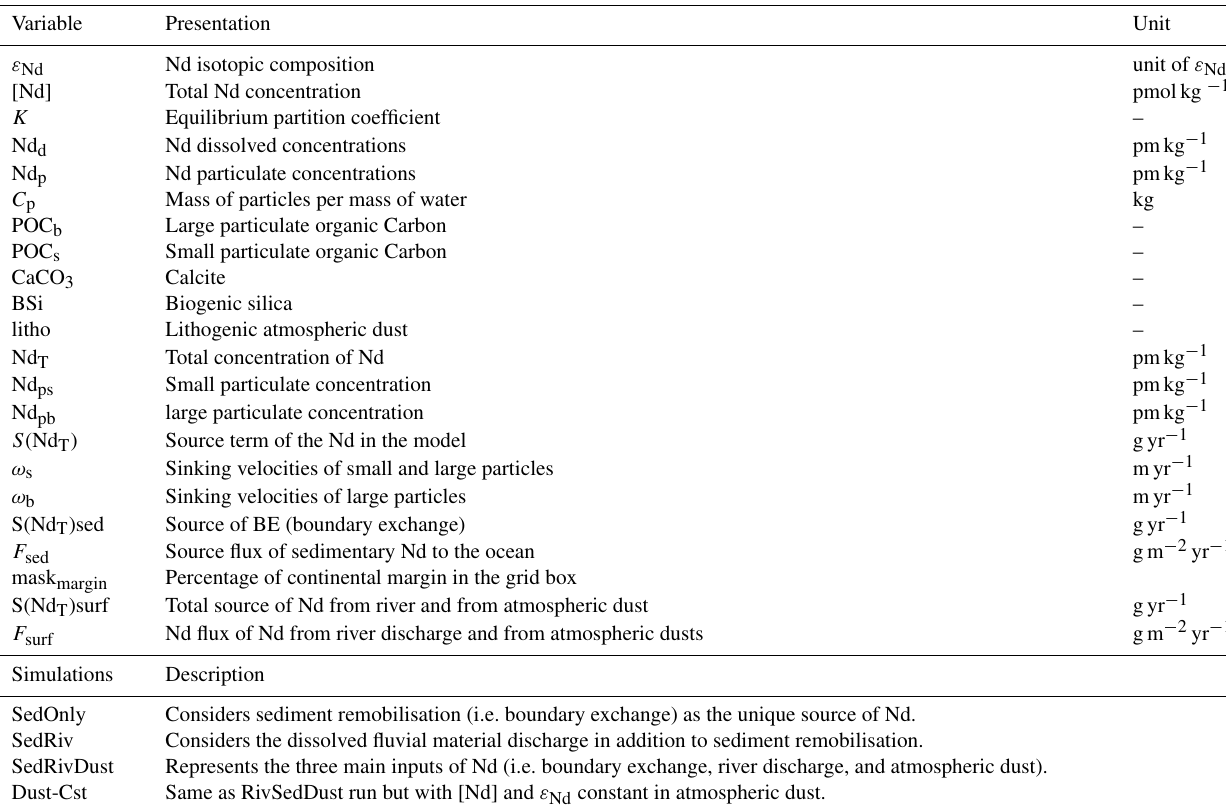
Table 1. List of variables and units and presentation of all simulations used in this study.